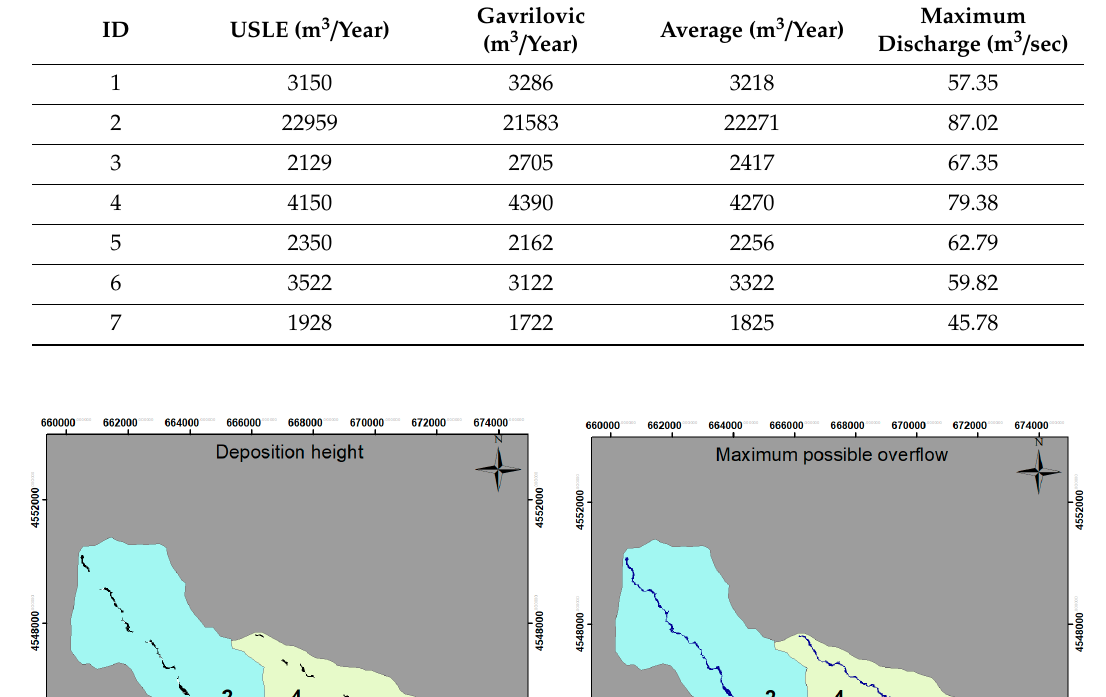
Table 2. Debris flow values of Gavrilovic and USLE methods and maximum possible discharge.